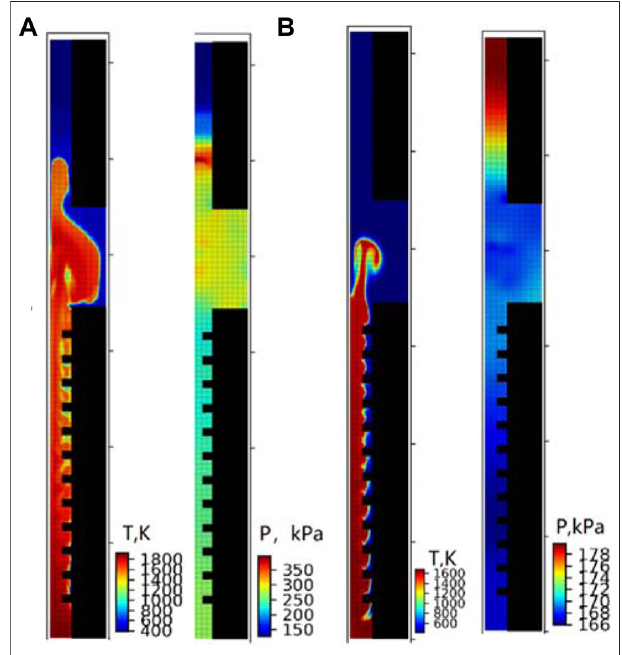
FIGURE 4 | X-Z view of temperature and pressure of RUT calculation. (A) S t (cid:1) 770 m / s -0.23. (B)